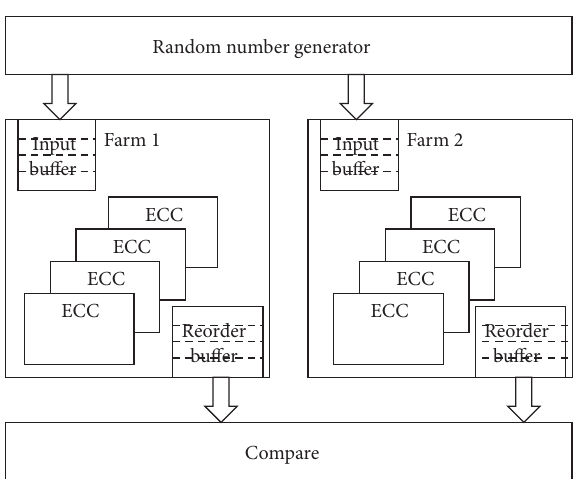
Figure 5: Top level block diagram of the elliptic curve cryptography processor server farm and the test